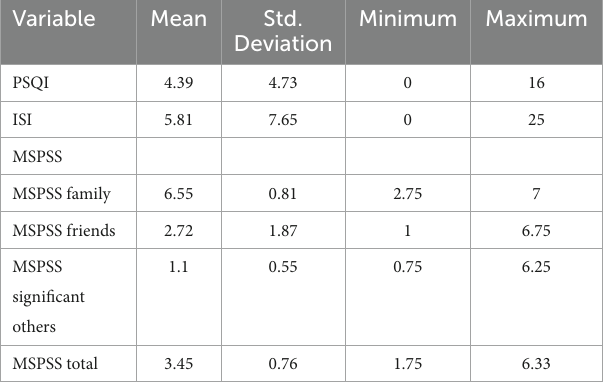
TABLE 2 Descriptive characteristics for the PSQI, ISI, and MSPSS ( n = 200).